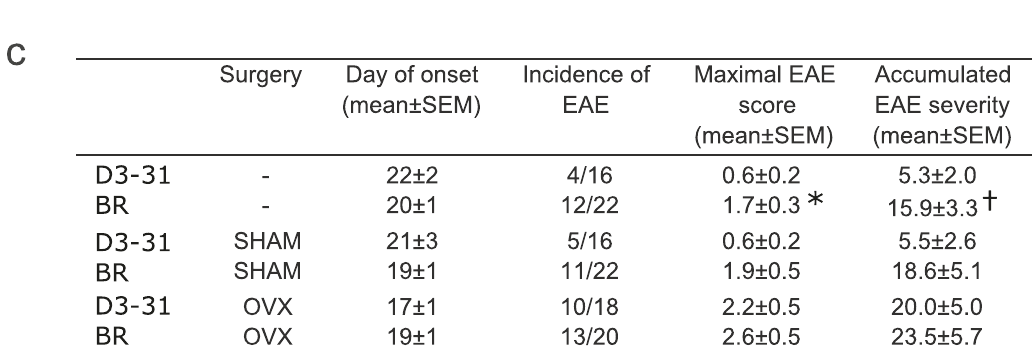
Fig. 3 Female sex hormones are required for the protective phenotype in D3-31 mice. a CIA severity and incidence (in parenthesis) in ovariectomized D3-31 and BR mice. Data was pooled from two independent experiments. b Incidence of EAE in ovariectomized (OVX) and sham operated (SHAM) D3-31 and BR mice. c Table comparing incidence, maximal score and accumulated severity of the EAE experiment shown in b . Data was pooled from three independent experiments. Data are summarised as mean (SEM). Statistical signi fi cance was evaluated using a two-tailed non-parametric Mann – Whitney U test. * P = 0.0486; † P =